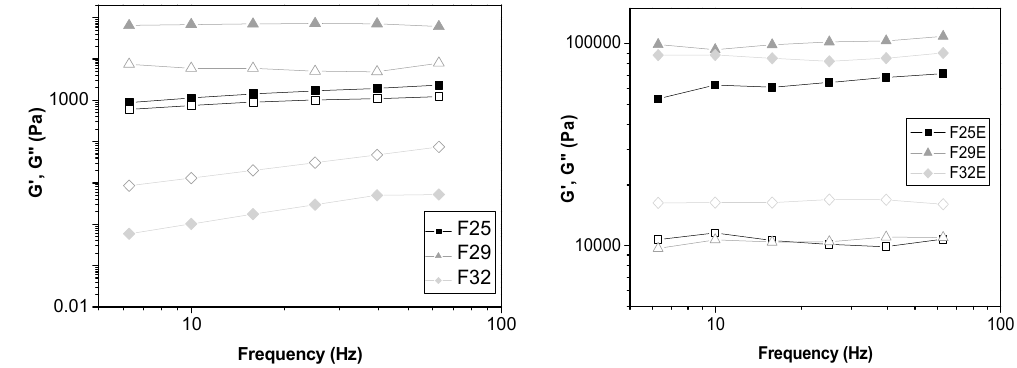
Figure 4. Frequency sweep profile of the storage modulus G ’ (closed symbols) and loss modulus G ” (opened symbols) of all formulations.